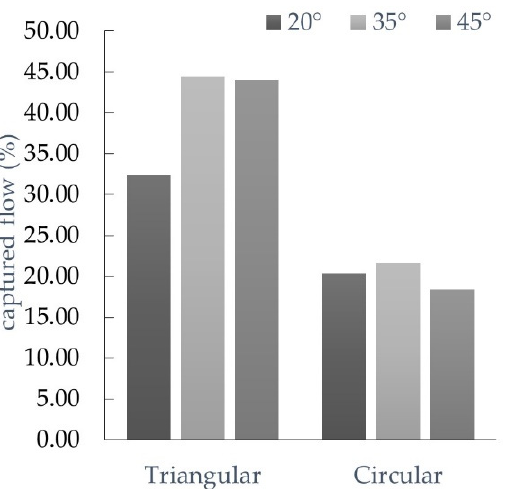
Figure 6. Graph of the clean water flow captured by a triangular and circular wire screen.